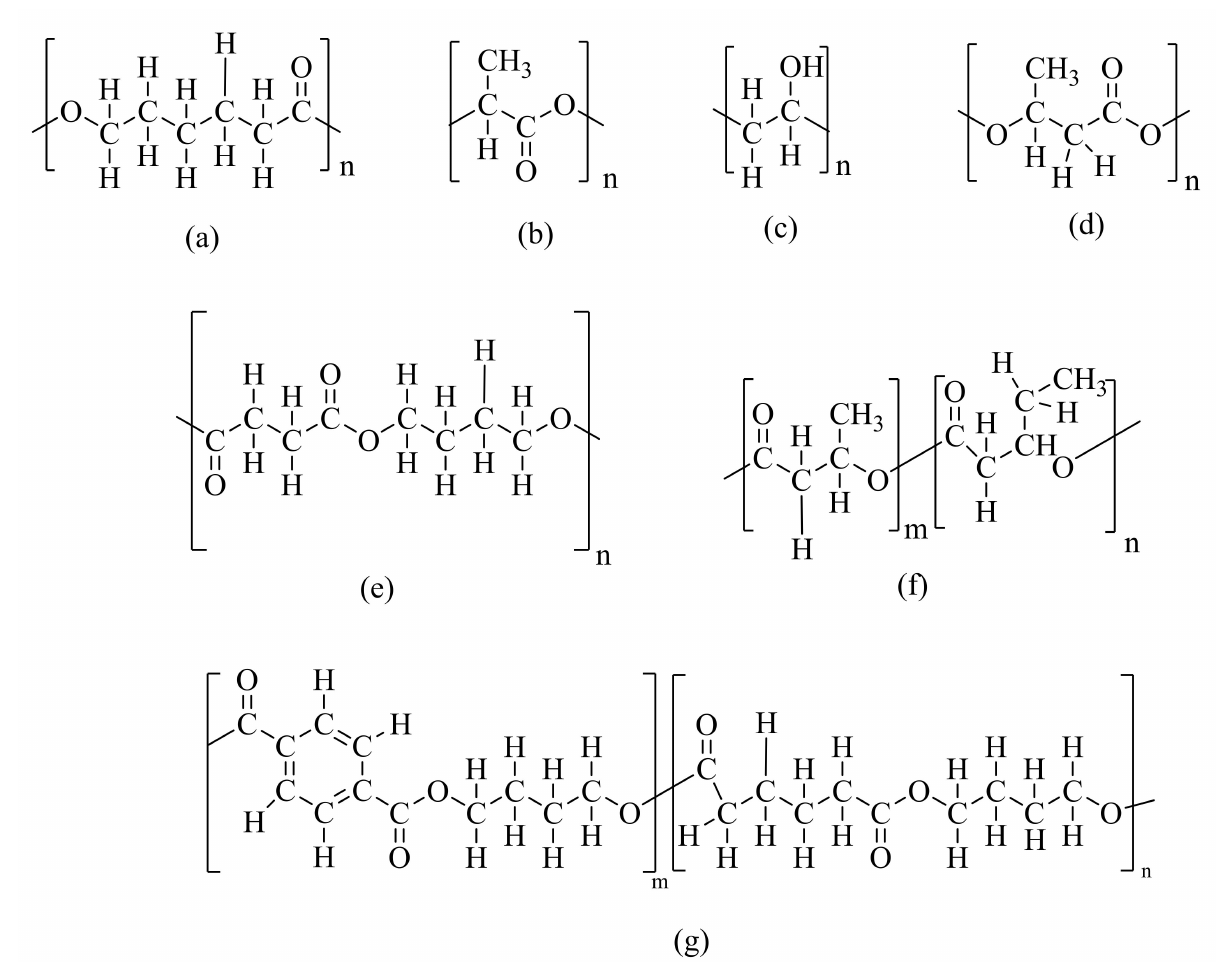
Figure 3. Chemical structures of ( a ) Polycaprolactone ( b ) Polylactic acid ( c ) Polyvinylalchohol ( d ) Polyhydroxybutyrate ( e ) Polybutylene succinate ( f ) Poly(3-hydroxybutryate- co -3-hydroxyvalerate) and ( g ) Poly(butylene adipate- co